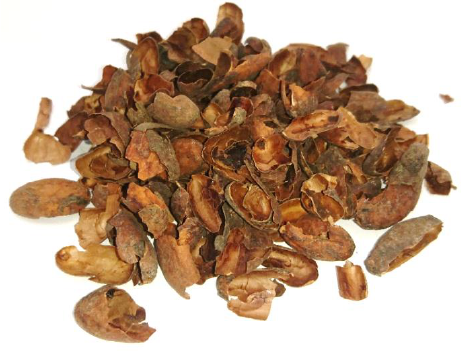
Figure 1. Cocoa shells obtained after roasting beans.